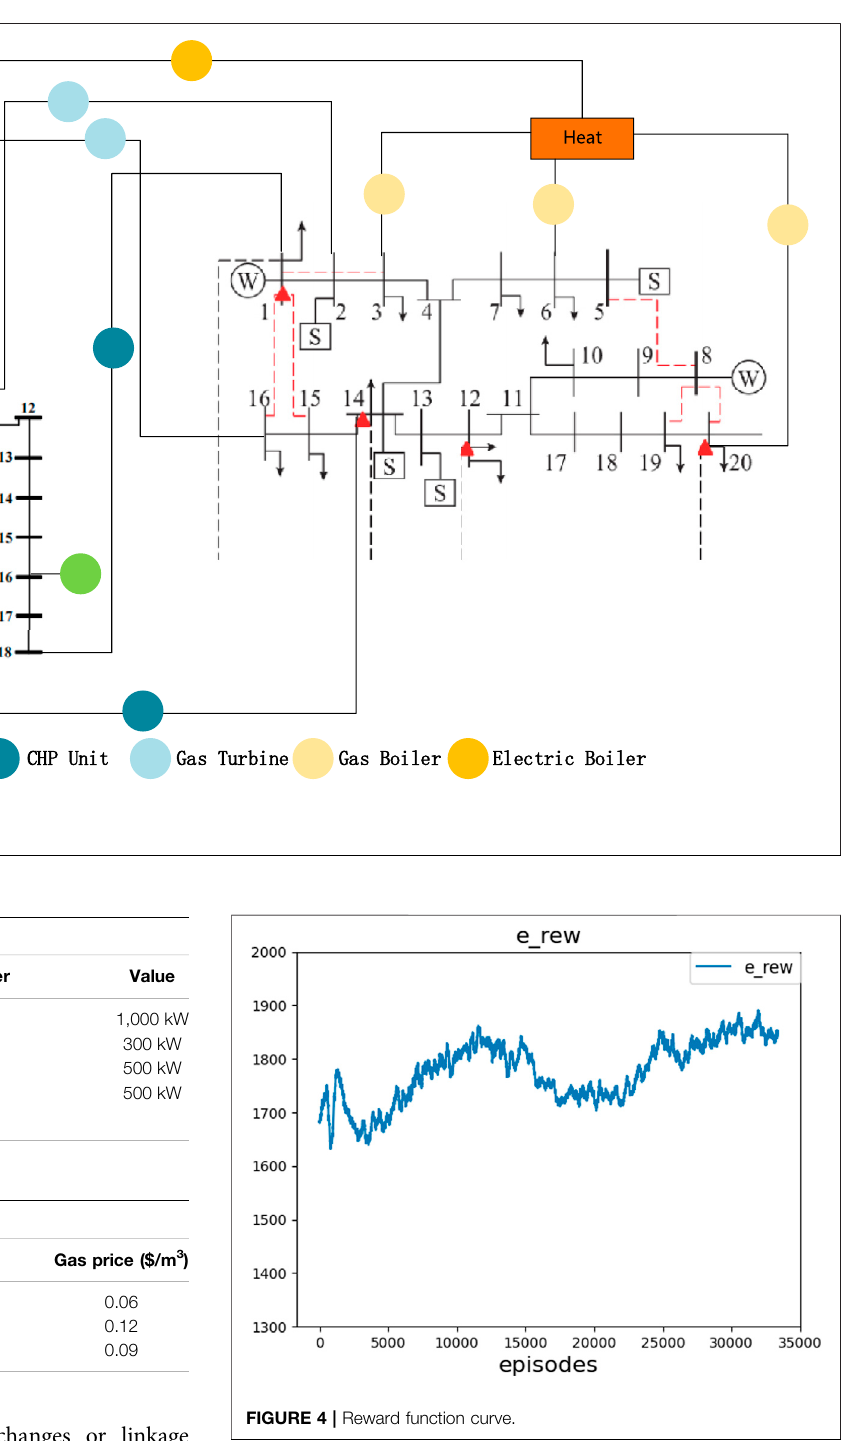
FIGURE 4 | Reward function